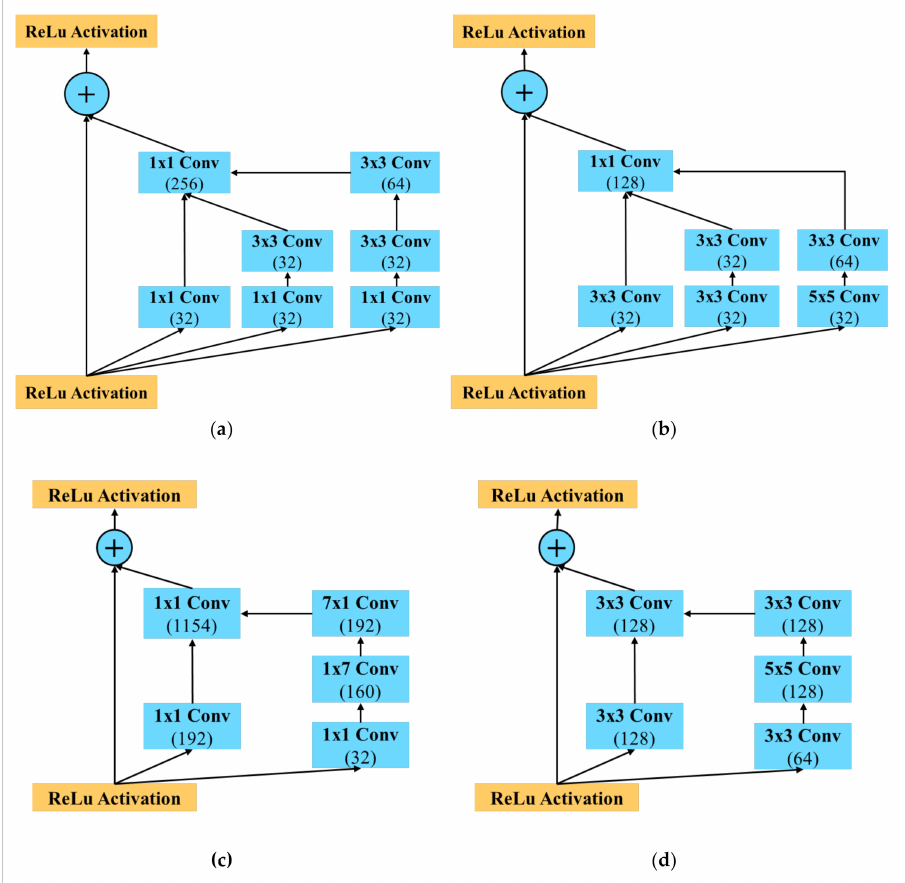
Figure6. Inceptionstructuremodification: ( a )Inception-ResNet-Astructurewithtwo3 × 3convolutions, ( b ) modified structure based on Inception-ResNet-A, ( c ) Inception-ResNet-B structure with 1 × 7 and 7 × 1 convolutions, ( d ) modified structure based on